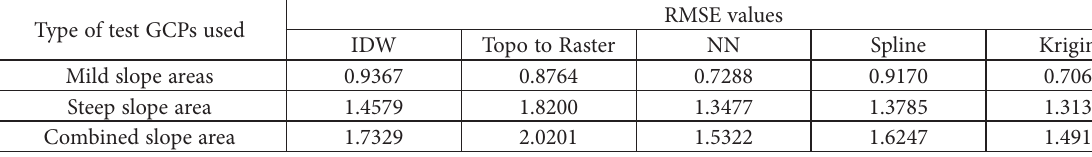
Combined slope area